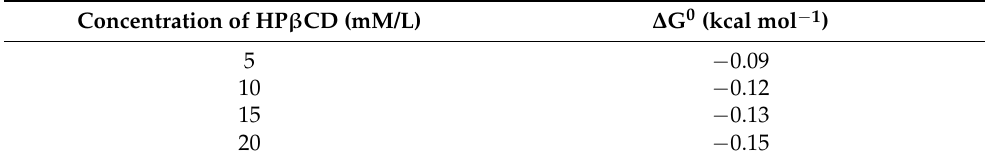
Table 1. Gibbs free energy of the DEX–CD complex in water at 25 ± 2 ◦ C.